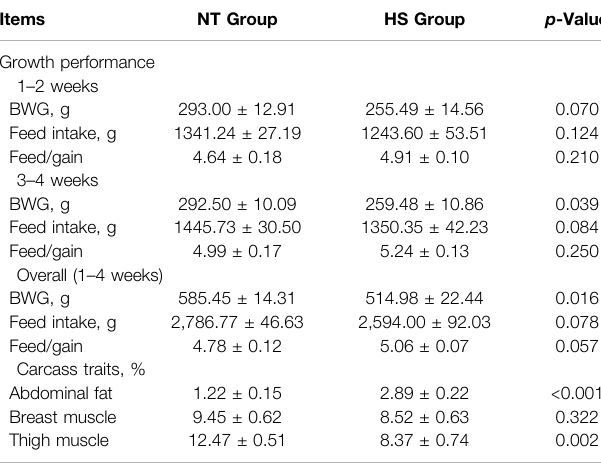
TABLE 2 | Effects of heat stress on growth performance and carcass traits in indigenous